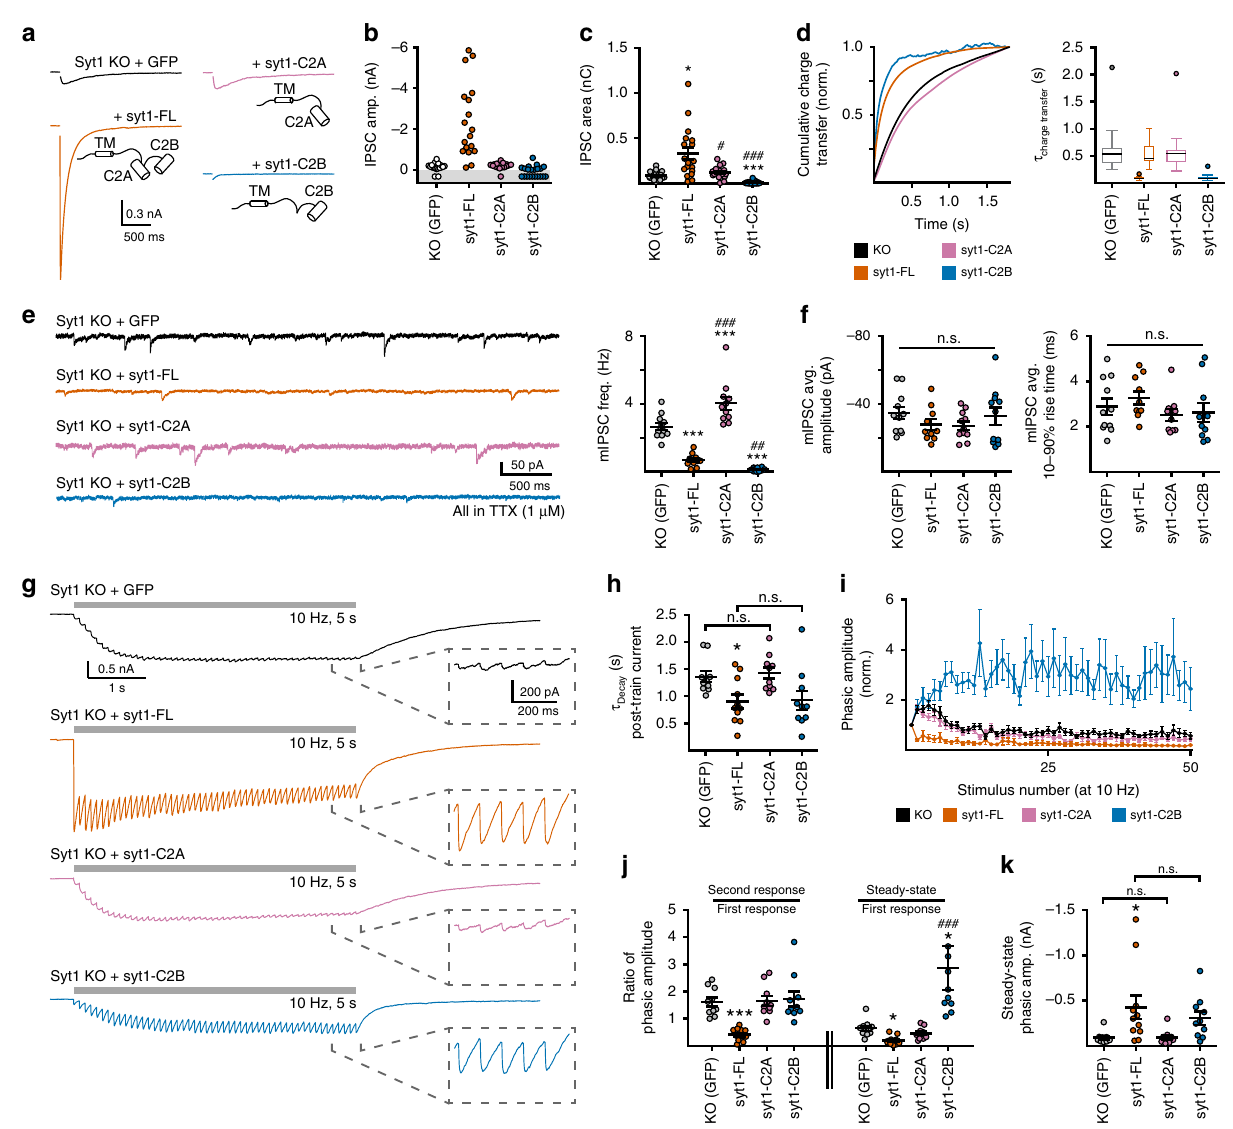
Fig. 2 Individual C2-domains of syt1 differentially in fl uence synaptic transmission. a Averaged evoked GABA A -receptor mediated IPSCs from syt1 KO neurons expressing a control virus (GFP, black), syt1-FL (orange), syt1-C2A (pink), or syt1-C2B (blue). b , c Quanti fi cation of the amplitude ( b ) and total charge ( c ) of the single-stimulation evoked IPSCs. In the amplitude graph ( b ), points in the gray shaded region of the graph indicate trials in which a response could not be evoked. d Graph (left) and quanti fi cation (right) of the cumulative charge transfer. Although neurons expressing syt1-FL required a double exponential, all other conditions were well fi tted by a single exponential. The box plot is in the Tukey style: the center line is the median, the bounds are the fi rst and third quartiles, and the whiskers are 1.5x the interquartile range. e Example traces (left) and quanti fi cation (right) of the frequency of spontaneous GABA A -receptor mediated mIPSCs in syt1 KO neurons expressing the indicated constructs. f Neither the amplitude (left) nor rise kinetics (right) of quantal responses were altered by the expression of the various syt1 constructs. g Average traces in response to train stimulation (10 Hz, 5 s) in syt1 KO neurons expressing the indicated constructs. Inset. Expanded view of the responses to the last 5 stimulations in the train. h Quanti fi cation of the post-train, delayed asynchronous component of release as fi tted by a single exponential. i Quanti fi cation of the phasic amplitude (normalized to the fi rst response) for each construct. j Quanti fi cation of the paired-pulse ratio (2nd response/1st response, left) and the steady-state ratio (average of the fi nal 5 responses/1st response, right) for each construct. k Quanti fi cation of the steady-state amplitude for each condition. Note that while syt1-C2B expressing neurons initially have little release, they facilitate over the course of the train to near syt1-FL-mediated levels of release. Except where otherwise noted, stars (*) indicate statistical comparisons to neurons expressing the control virus; hash symbols (#) indicate statistical comparisons to neurons expressing syt1-FL. For all fi gures, # p < 0.05, ## p < 0.01; and ### p < 0.001. Error bars represent